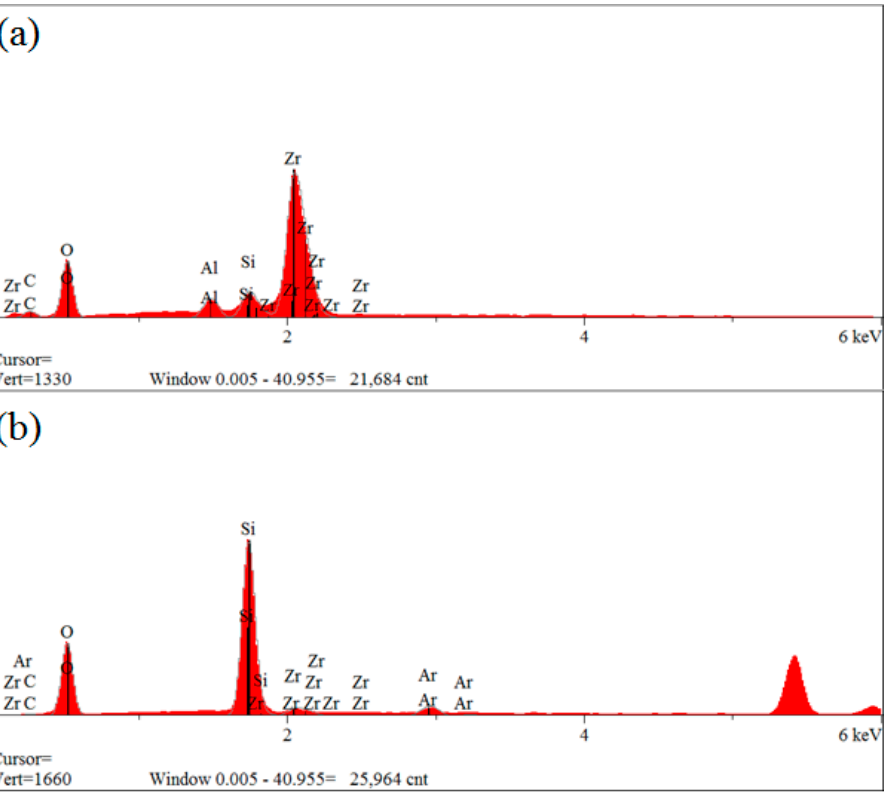
Figure 2. The EDX analysis of and ( a ) TSC and ( b ) PVD-coated zirconia surfaces. Table 2. EDX elemental analysis of PVD and TSC coatings. Element TSC (at.%) PVD (at.%) C